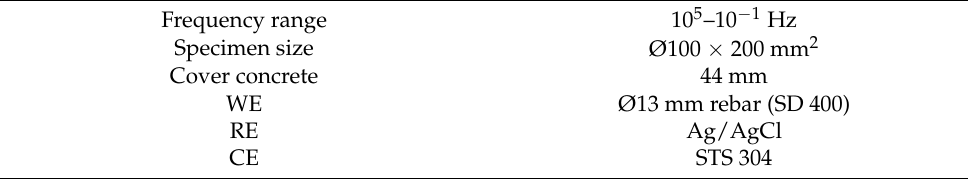
Table 4. Electrochemical experiment